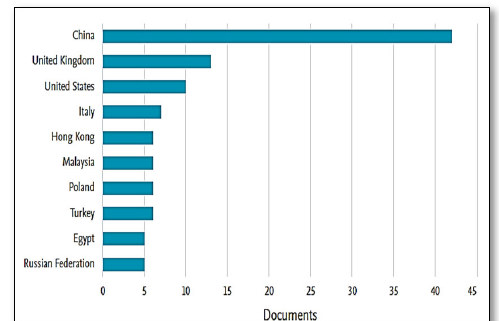
Fig. 1a. The number of documents published referring to each year of the words “Artificial Intelligence”, “project management” of “construction” Source: Obtained from